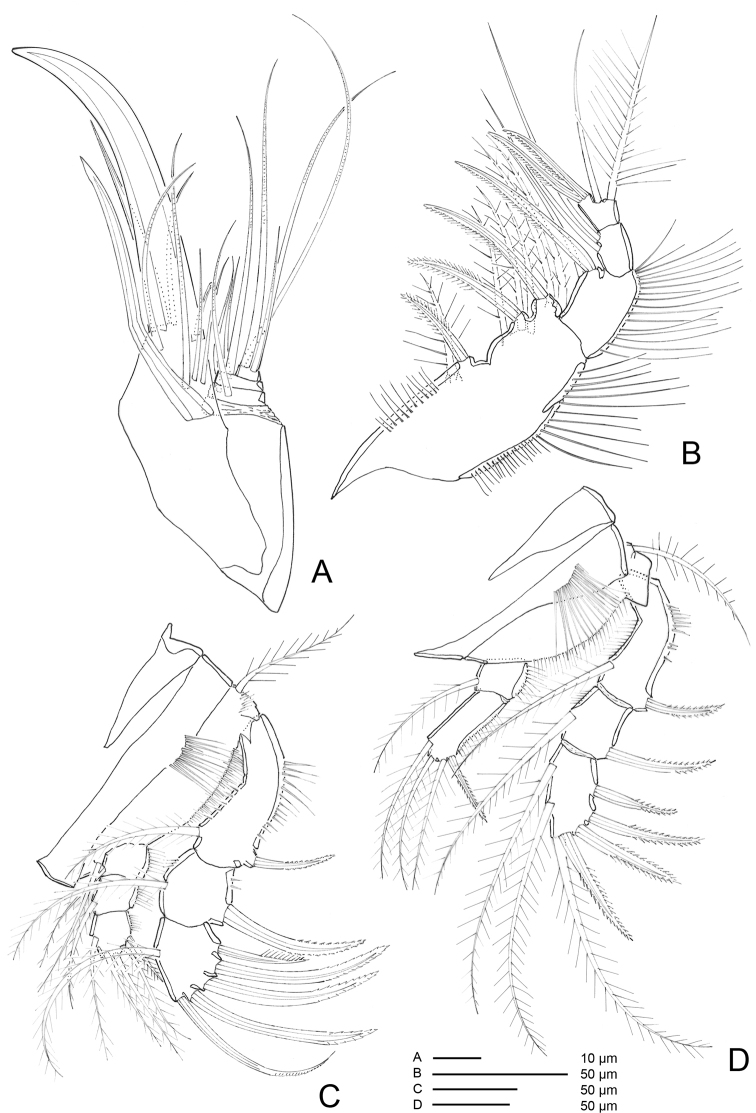

Hase
talpamorphicus gen. et sp. n. Holotype (female) (M85/3, 1164): A
Mx2
enp
B
Mxp
CP1
DP2.